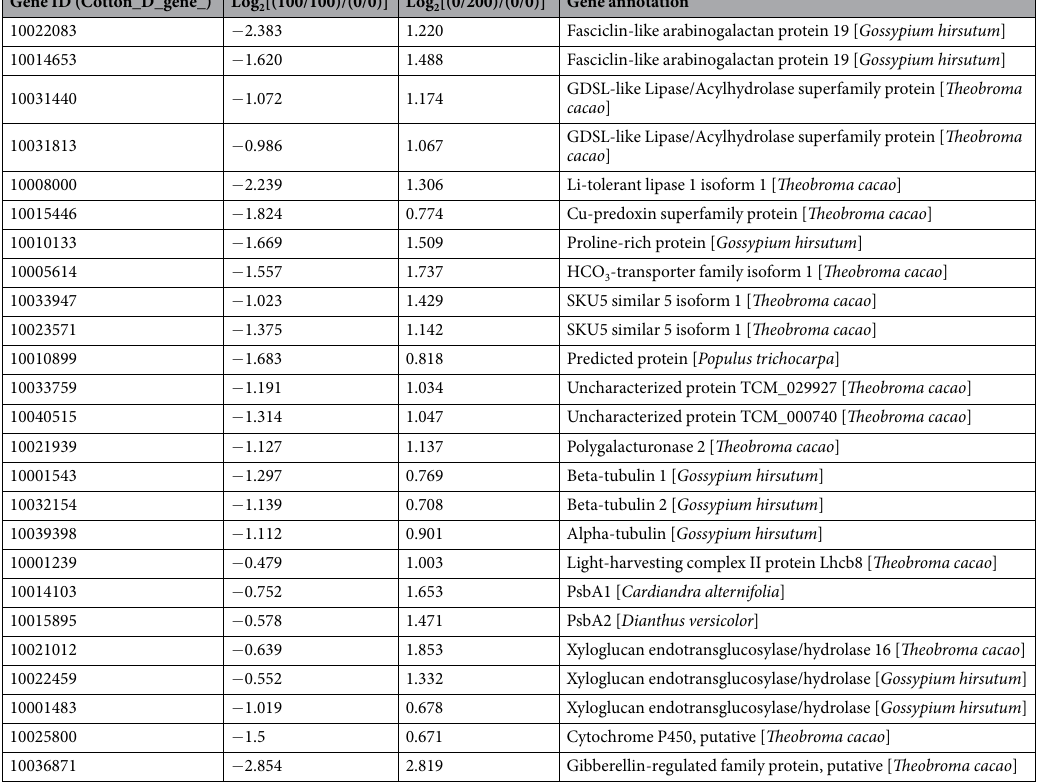
Table 1. Summary of differentially expressed genes in leaves which were significantly up-regulated in non- uniform treatment but down-regulated in uniform treatment or